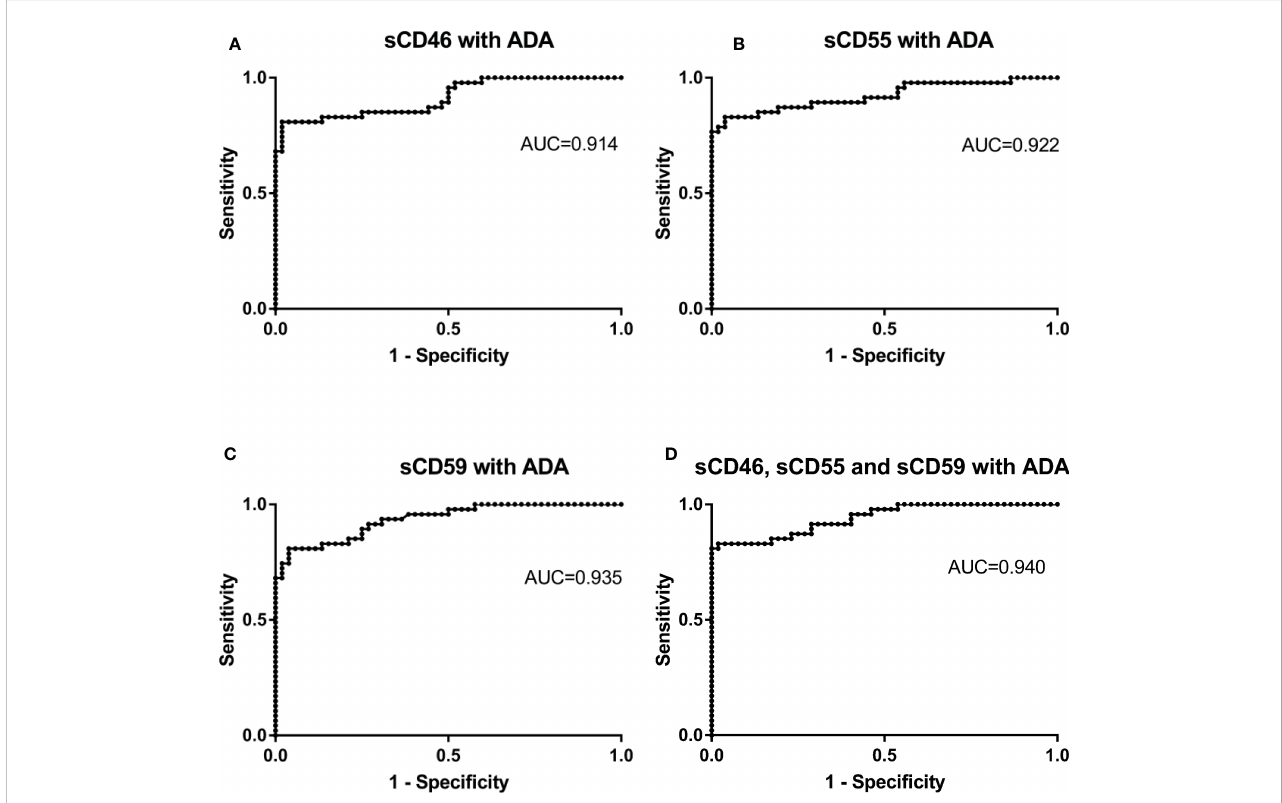
FIGURE 6 Receiver operating characteristic curves of combine detection of sCD46. sCD55, sCD59 and ADA for differential diagnosis in TPE (N=47) and non-TPE (N=52). (A) the ROC curves of combined detection of Pleural Fluid sCD46 and ADA. (B) the ROC curves of combined detection of Pleural Fluid sCD55 and ADA. (C) the ROC curves of combined detection of Pleural Fluid sCD59 and ADA. (D) the ROC curves of combined detection of Pleural Fluid sCD46, sCD55, sCD59, and